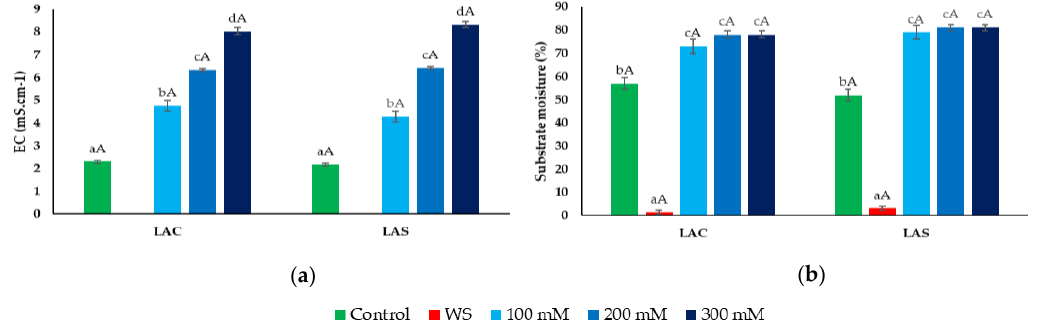
Figure 1. Substrate electrical conductivity (EC) ( a ), and moisture (%) ( b ), after 30 days of control, water deficit (WS) or salt stress (100, 200, 300 mM NaCl) treatments. Values shown are means ± SE (n = 5). Different lowercase letters above the bars indicate significant differences between treatments for each variety (LAC: Lavandula angustifolia var. Codreanca; LAS: L. angustifolia var. Sevtopolis), and different uppercase letters indicate significant differences between the two varieties for pots that underwent the same treatment, according to the Tukey test (α = 0.05).